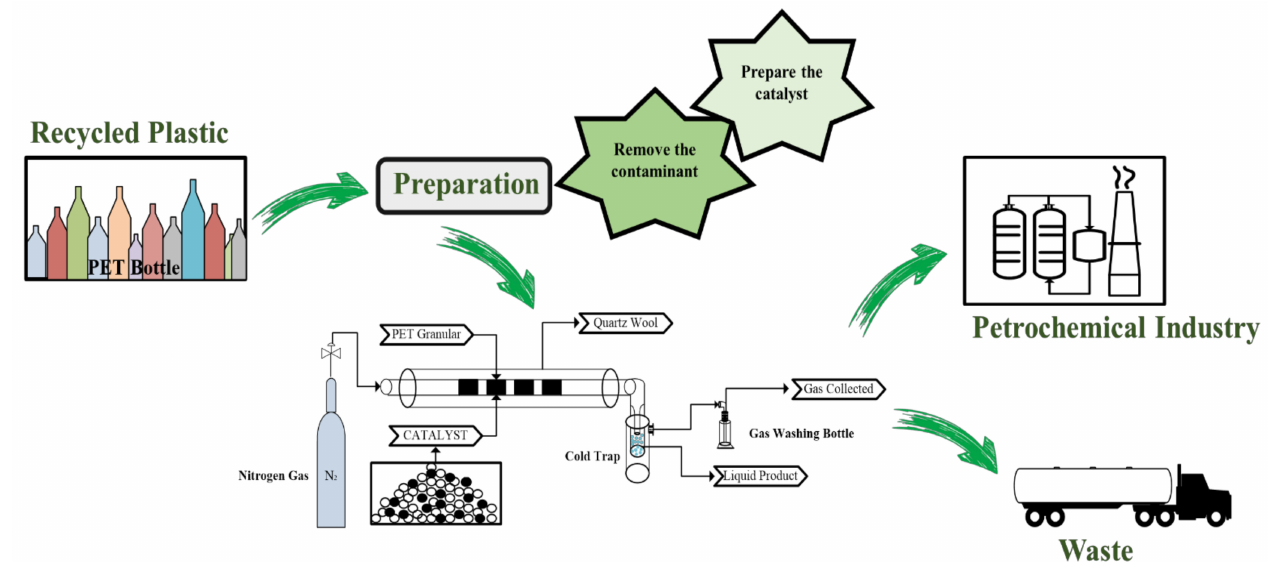
Figure 5. Schematic of PET pyrolysis by a tube